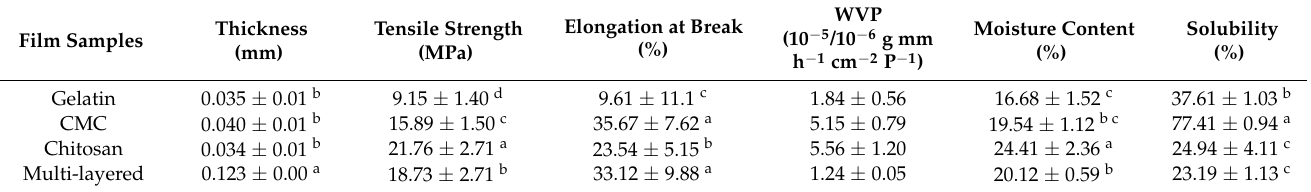
Table 1. Mechanical and physico-chemical properties of the biopolymer-based monolayer and multi-layer films incorporated with RCE.